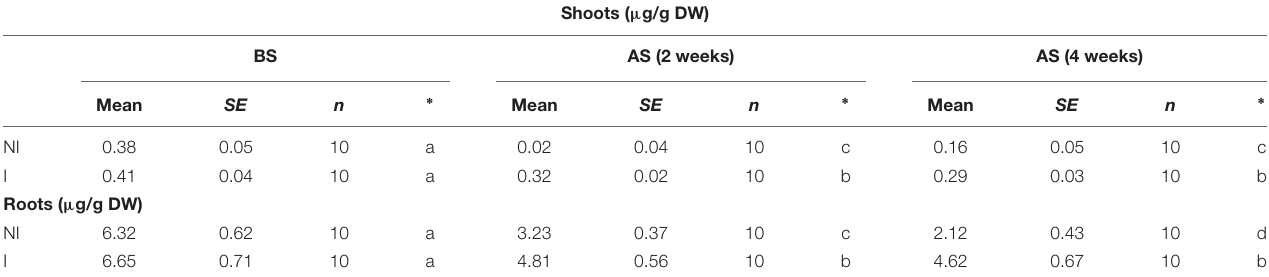
TABLE 1 | Effects of B. licheniformis SA03 on shoot and root Fe concentrations in Chrysanthemum plants before (BS) or after (AS) saline–alkaline treatments.